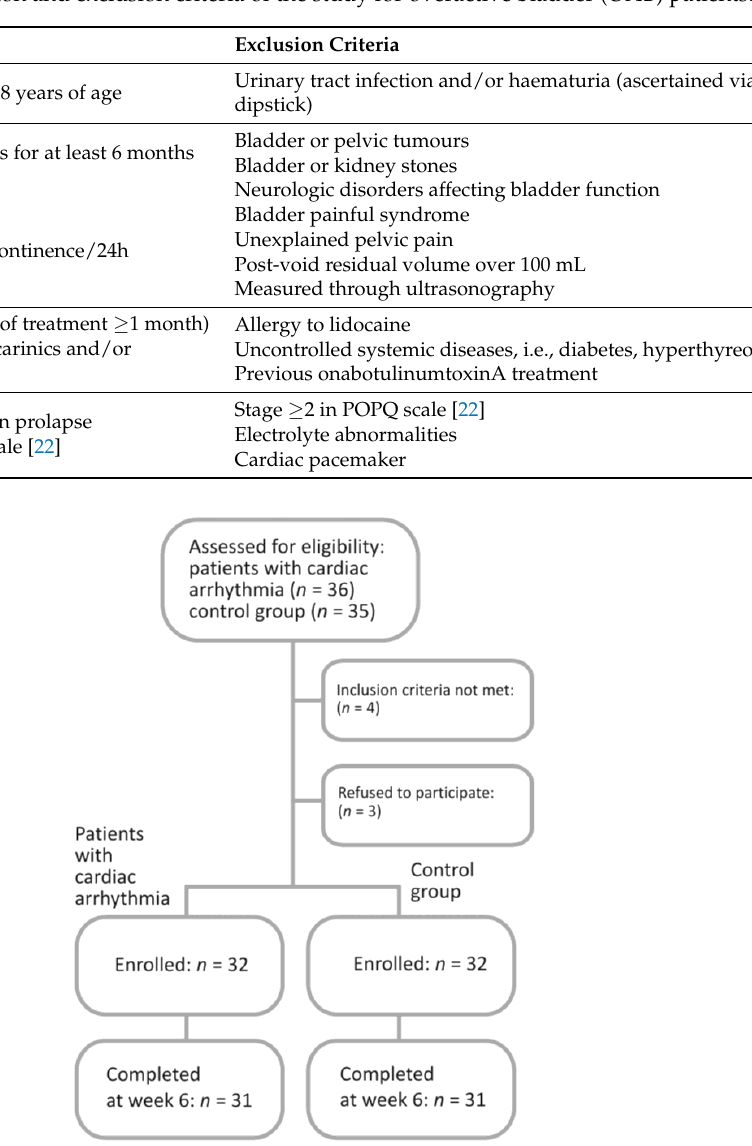
Table 1. Inclusion and exclusion criteria of the study for overactive bladder (OAB) patients.